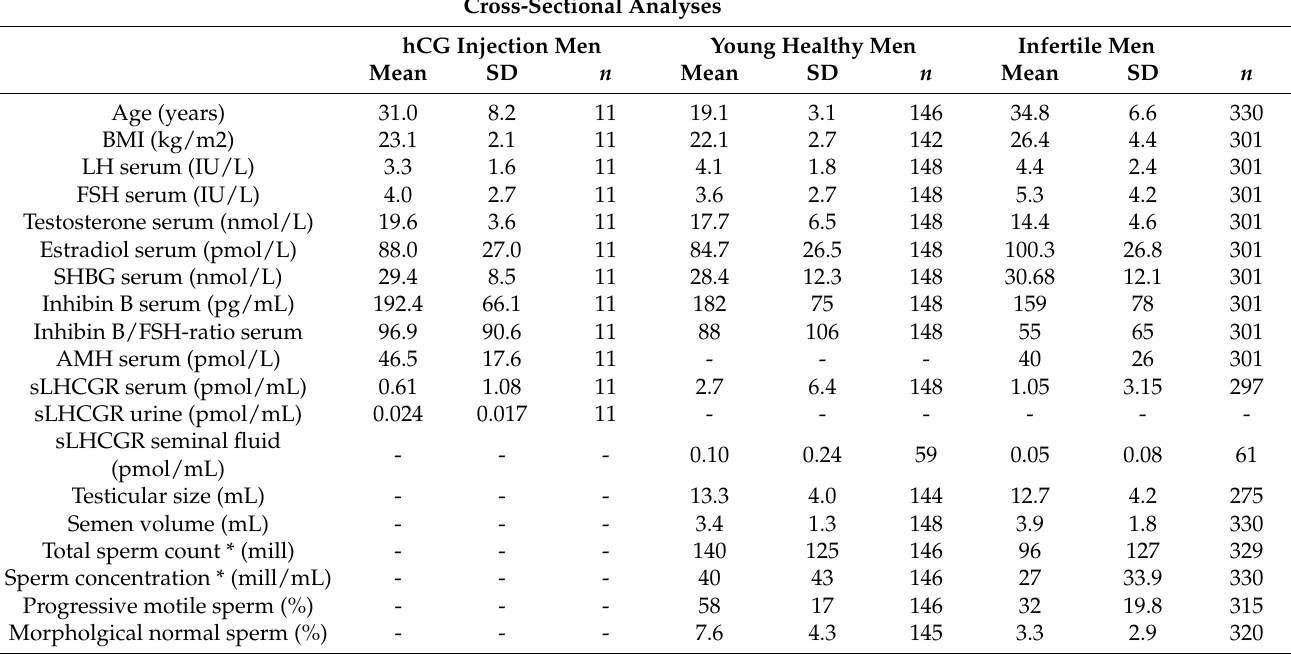
Table 1. Baseline characteristics of 11 men receiving 5000 IU of human chorionic gonadotropin of 148 young men from the general population, and of 307 infertile men. * shows